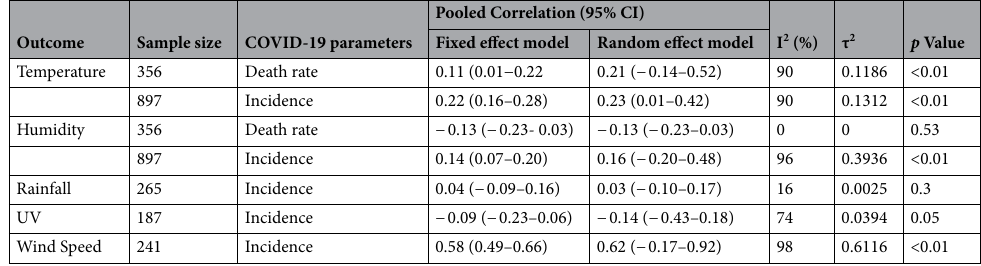
Table 5. Overall